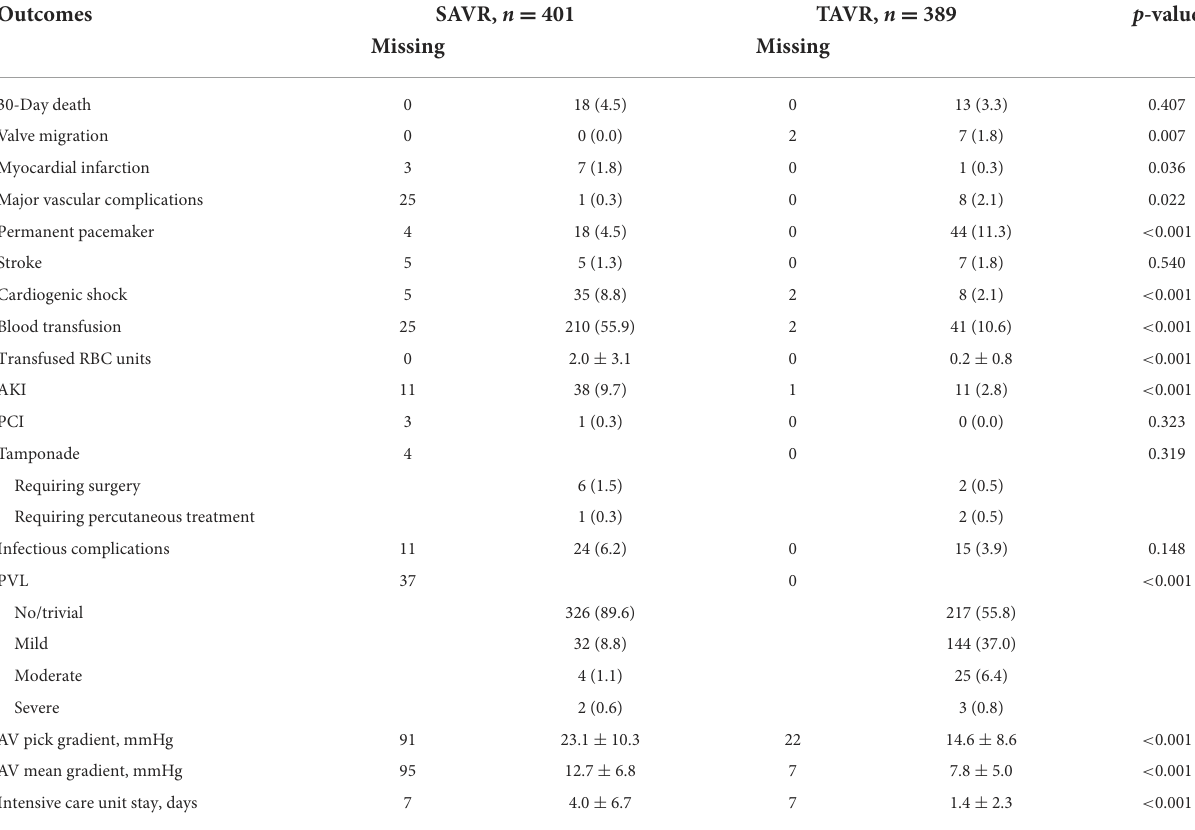
TABLE 5 Early outcome of patients with LFLG AS treated with TAVR or